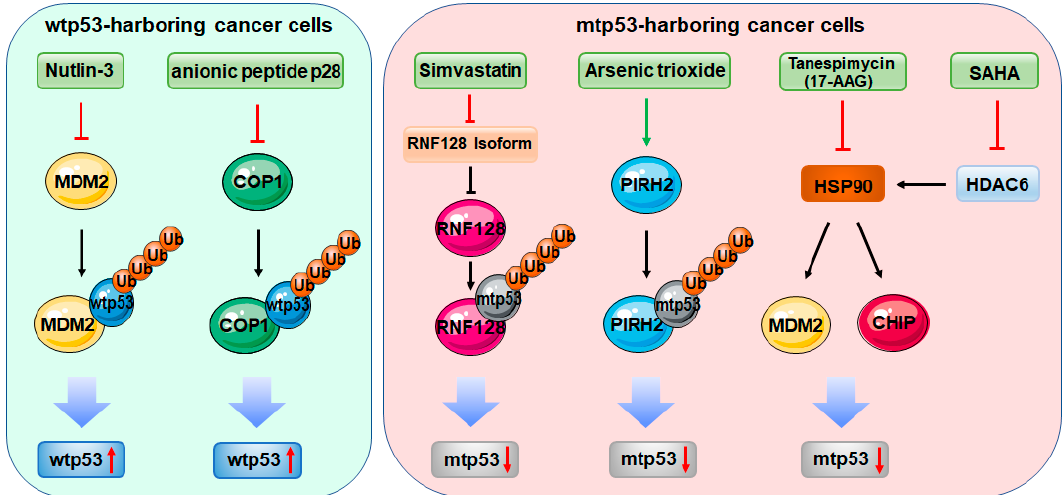
Figure 1. Therapeutic approaches targeting E3 ligases in the context of p53. In wild-type p53 (wtp53)-harboring cancer cells, Nutlin-3 and its derivatives and the anionic peptide p28 stabilize and activate wtp53 by antagonizing MDM2 and COP1, respectively. In mutant p53 (mtp53)-harboring cancer cells, Simvastatin, arsenic trioxide, tanespimycin (17-AAG), and suberoylanilide hydroxamic acid (SAHA) induce mtp53 degradation by directly or indirectly targeting E3 ligases.